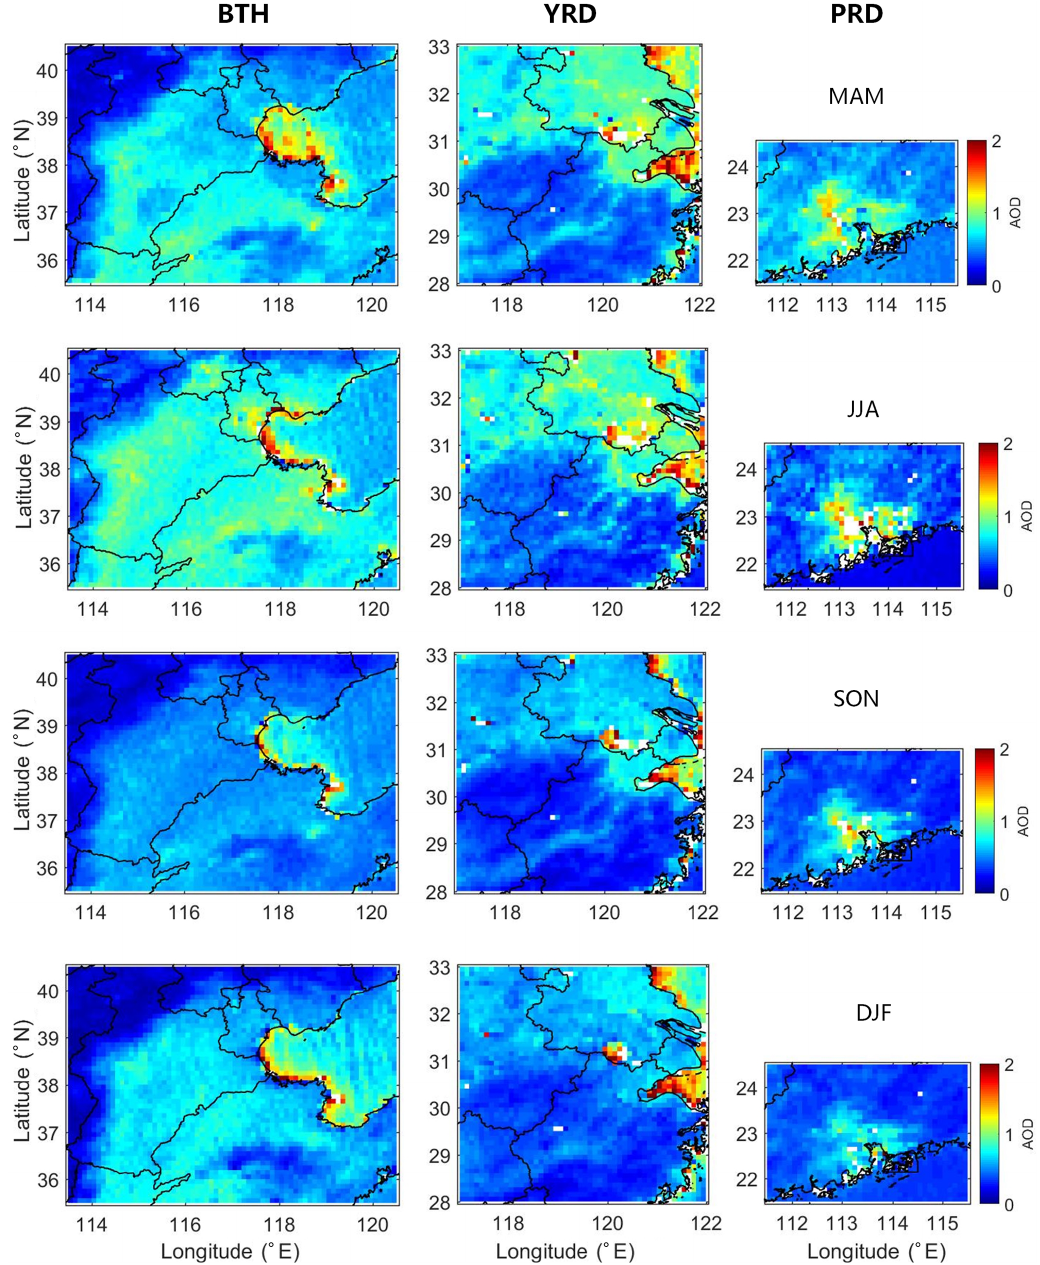
Figure 3. Spatial distributions of seasonally mean MODIS AOD over the BTH (left column), the YRD (middle column) and the PRD (right column), for spring (MAM), summer (JJA), autumn (SON) and winter (DJF) (top to bottom rows), averaged over the study period from 2007 to